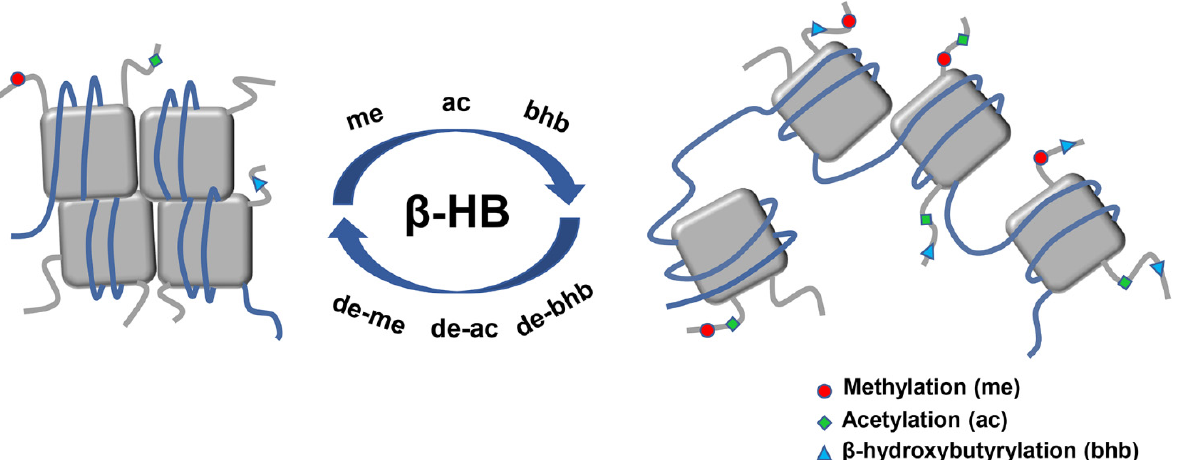
Figure 4. Main epigenetic alterations of histone posttranslational modifications induced by β -HB. Histone posttranslational modifications which relate to the epigenetic regulation of β -HB mainly consist of histone methylation, acetylation, as well as a new type of histone lysine bhb. β -HB administration alters the modification of chromatin conformation through the epigenetic pathway. Chromatin structure is represented by DNA (blue line) organized in nucleosomes formed by core histones (grey square). Abbreviations: ac, acetylation; bhb, β -hydroxybutyrylation; β -HB, β -hydroxybutyrate; me, methylation.